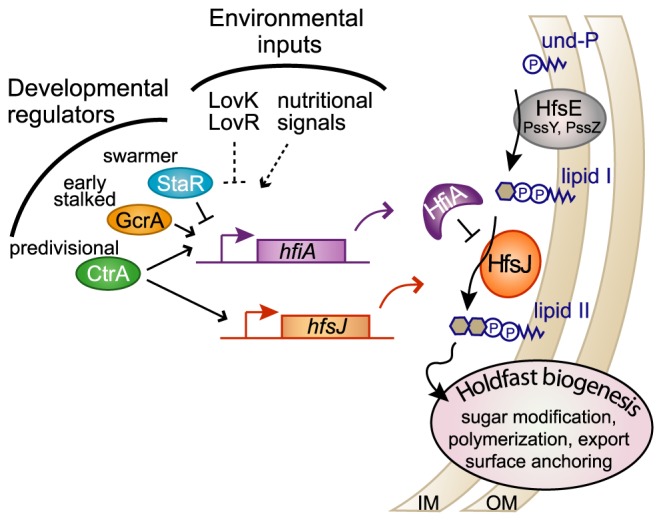
HfiA and HfsJ coordinately control holdfast development in response to cell cycle and environmental signals.Proposed model in which HfiA directly inhibits HfsJ, a WecG/TagA-family glycosyltransferase required for holdfast production. Expression of hfsJ and hfiA are controlled by cell cycle and environmental input signals. Solid and dashed lines indicate direct and indirect regulation respectively.